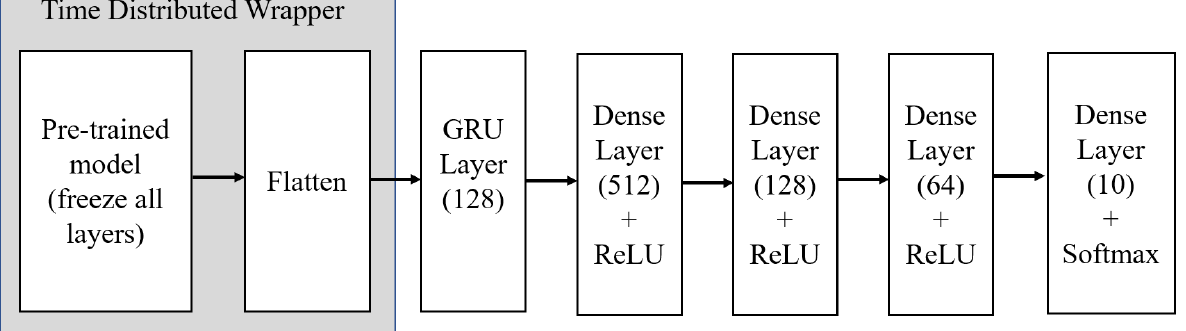
Figure 5. Overview of different pretrained model architectures. ReLU—rectified linear